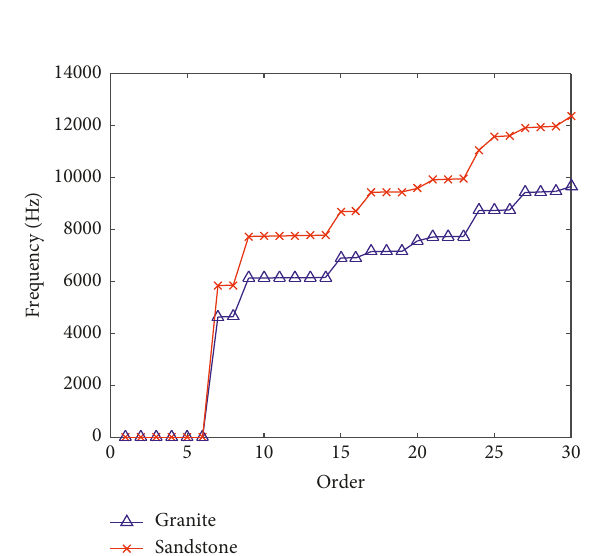
Figure 4: Modes in different orders of granite and